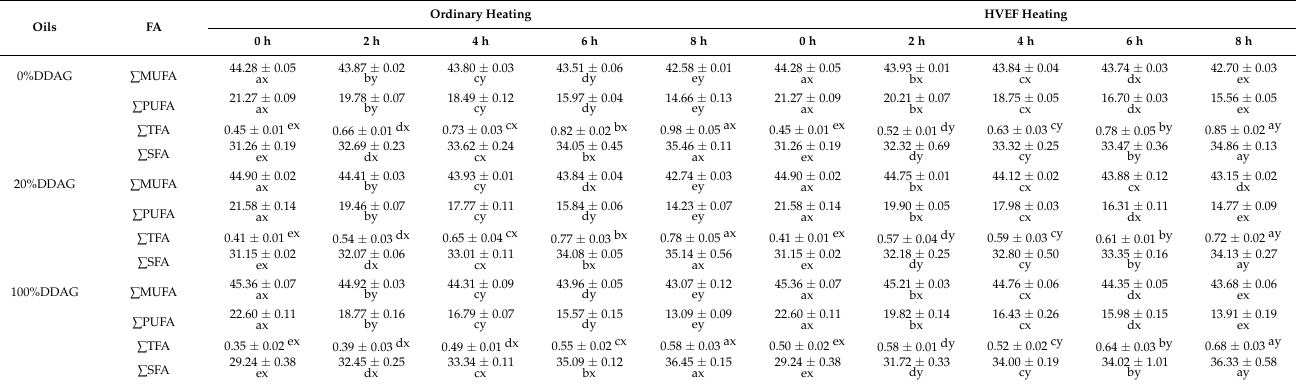
Table 3. The fatty acid content changes in 0%DDAG, 20%DDAG, and 100%DDAG during HVEF heating and ordinary heating at 180